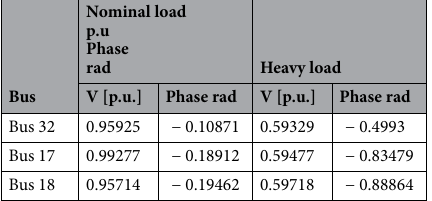
Table 4. Power flow results after adding SVC at bus 17.